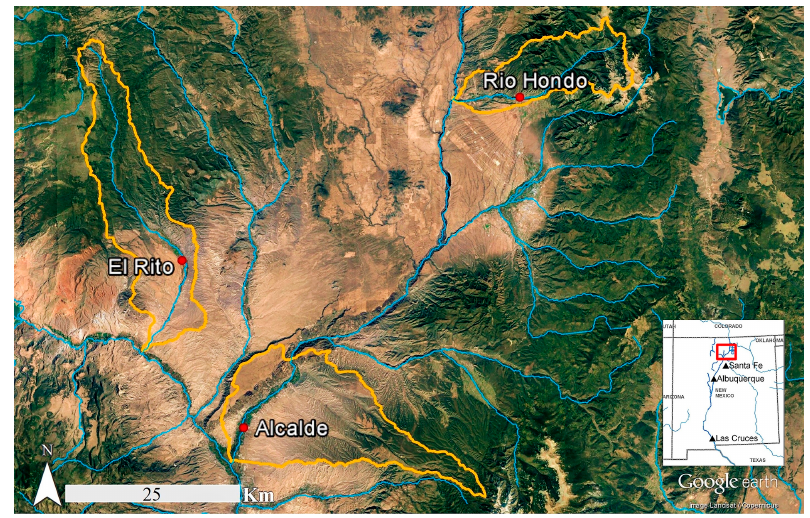
Figure 1. Map of the study area showing location of the study sites (red dots) in each irrigated valley within their watersheds.